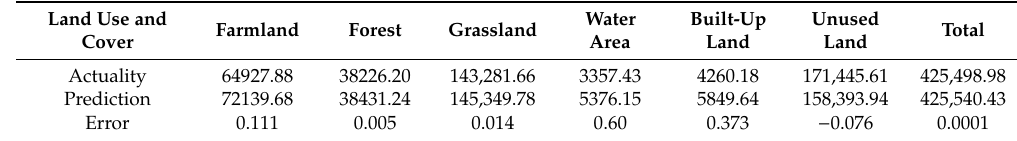
Figure 5. Predicted and actual land use and cover maps in 2015: ( a ) predicted land use maps by model; ( b ) actual maps from remote sensing. Table 7. Validation of predicted land use and cover in 2015 (km 2 ) .